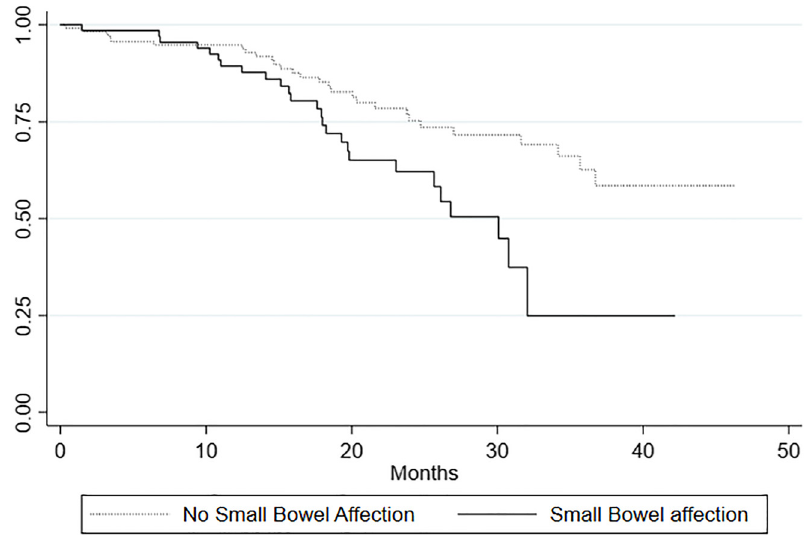
Figure 2: Survival by small bowel